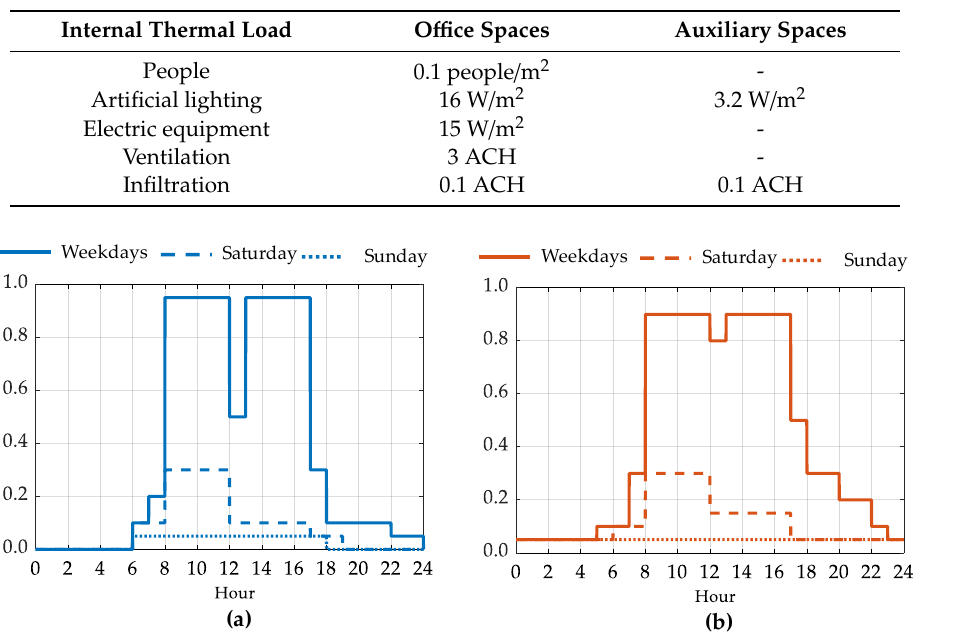
Table 2. The building’s internal thermal loads.